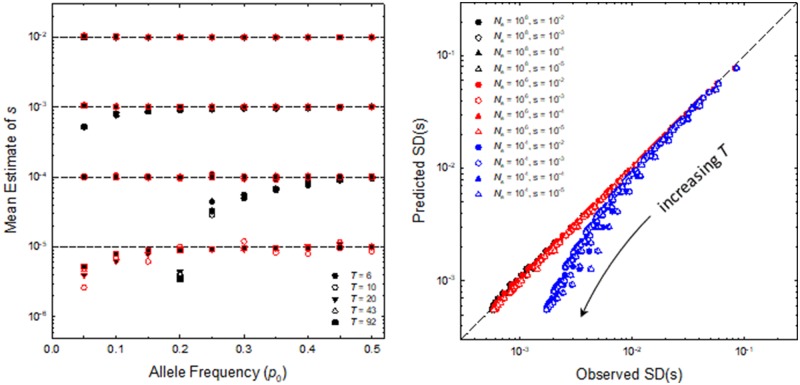
—(Left) Mean estimates of the selection coefficient s obtained from the least-squares regression approach. Each point is the average of the results from 107 simulations based on Wright–Fisher allele-frequency dynamics incorporating selection and drift, followed by random sampling of n = 100 diploid individuals at each sampling point. Black symbols are for effective population size Ne=104, and red for Ne=106, and results are reported for a range of starting allele frequencies, p0. The horizontal dashed lines denote the expectations for four evaluated selection coefficients (with temporal variance, σs2, equal to zero), and the different symbols denote experiments of different durations (T). (Right) Sampling standard deviations for estimates of s for the case of σs2=0, from simulations as noted above for three values of Ne, four of s, and a sample size of 100, compared with the theoretical expectation, equation (10). The diagonal dashed line denotes points of perfect agreement, and many symbols cannot be seen as they overlie each other on this line.